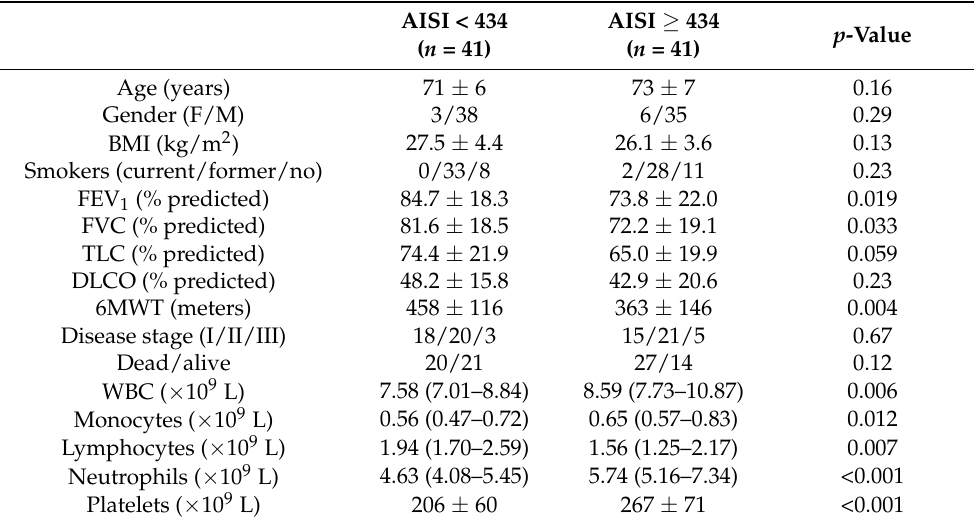
Table 6. Demographic, clinical, and haematological characteristics of IPF patients stratified by AISI